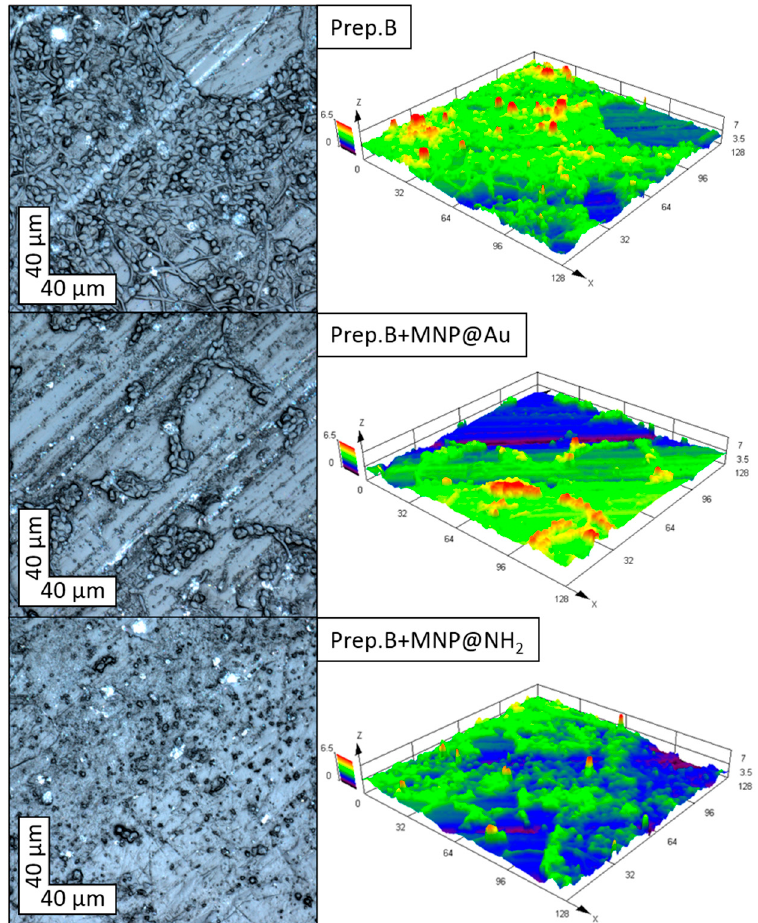
Figure 5. CLSM images of C. tropicalis 48 h biofilm treated with preparation B and preparation B with the addition of magnetic nanoparticles MNP@Au and MNP@NH 2 .